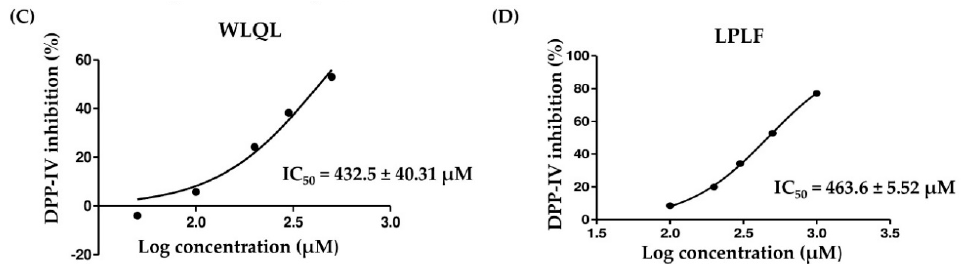
Figure A1. IC 50 values of ( A ) LPSW, ( B ) VPGLAL, ( C ) WLQL, and ( D ) LPLF on DPP-IV.